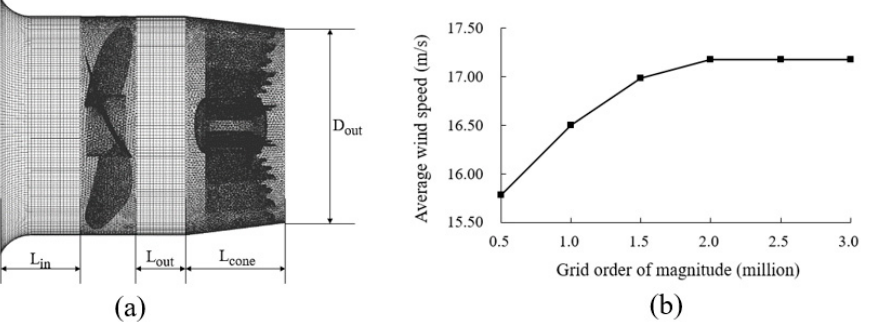
Figure 5. Mesh generation results and mesh independence verification. ( a )—Meshing results; ( b )— Grid independence verification results.